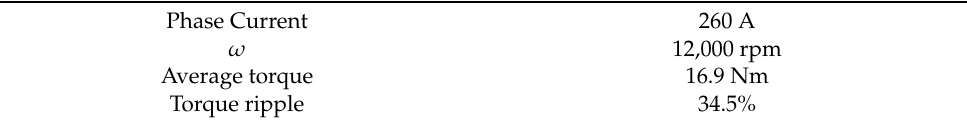
Table 6. Conventional SRM results.